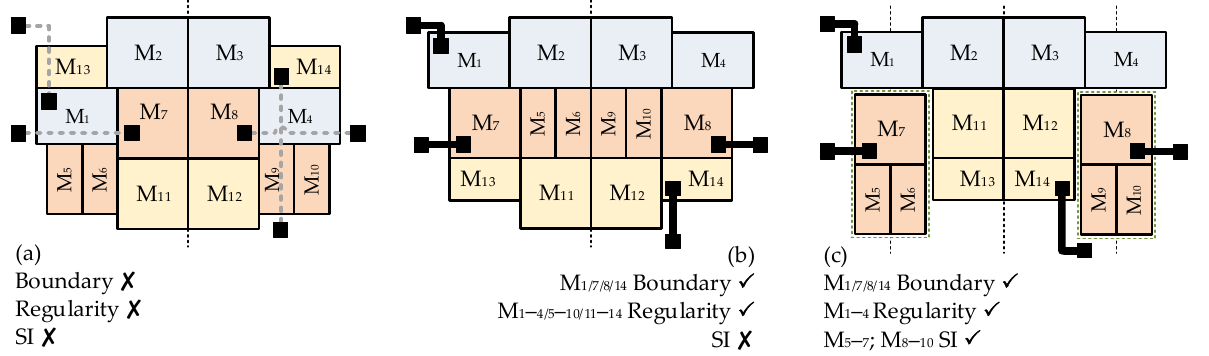
Figure 2. Three symmetric placements of the generic circuit: ( a ) Devices connected to the input/output ports are placed inside the circuit layout; ( b ) devices are placed within the circuit boundary and three horizontal regularity constraints are implemented; ( c ) two symmetry islands are formed.